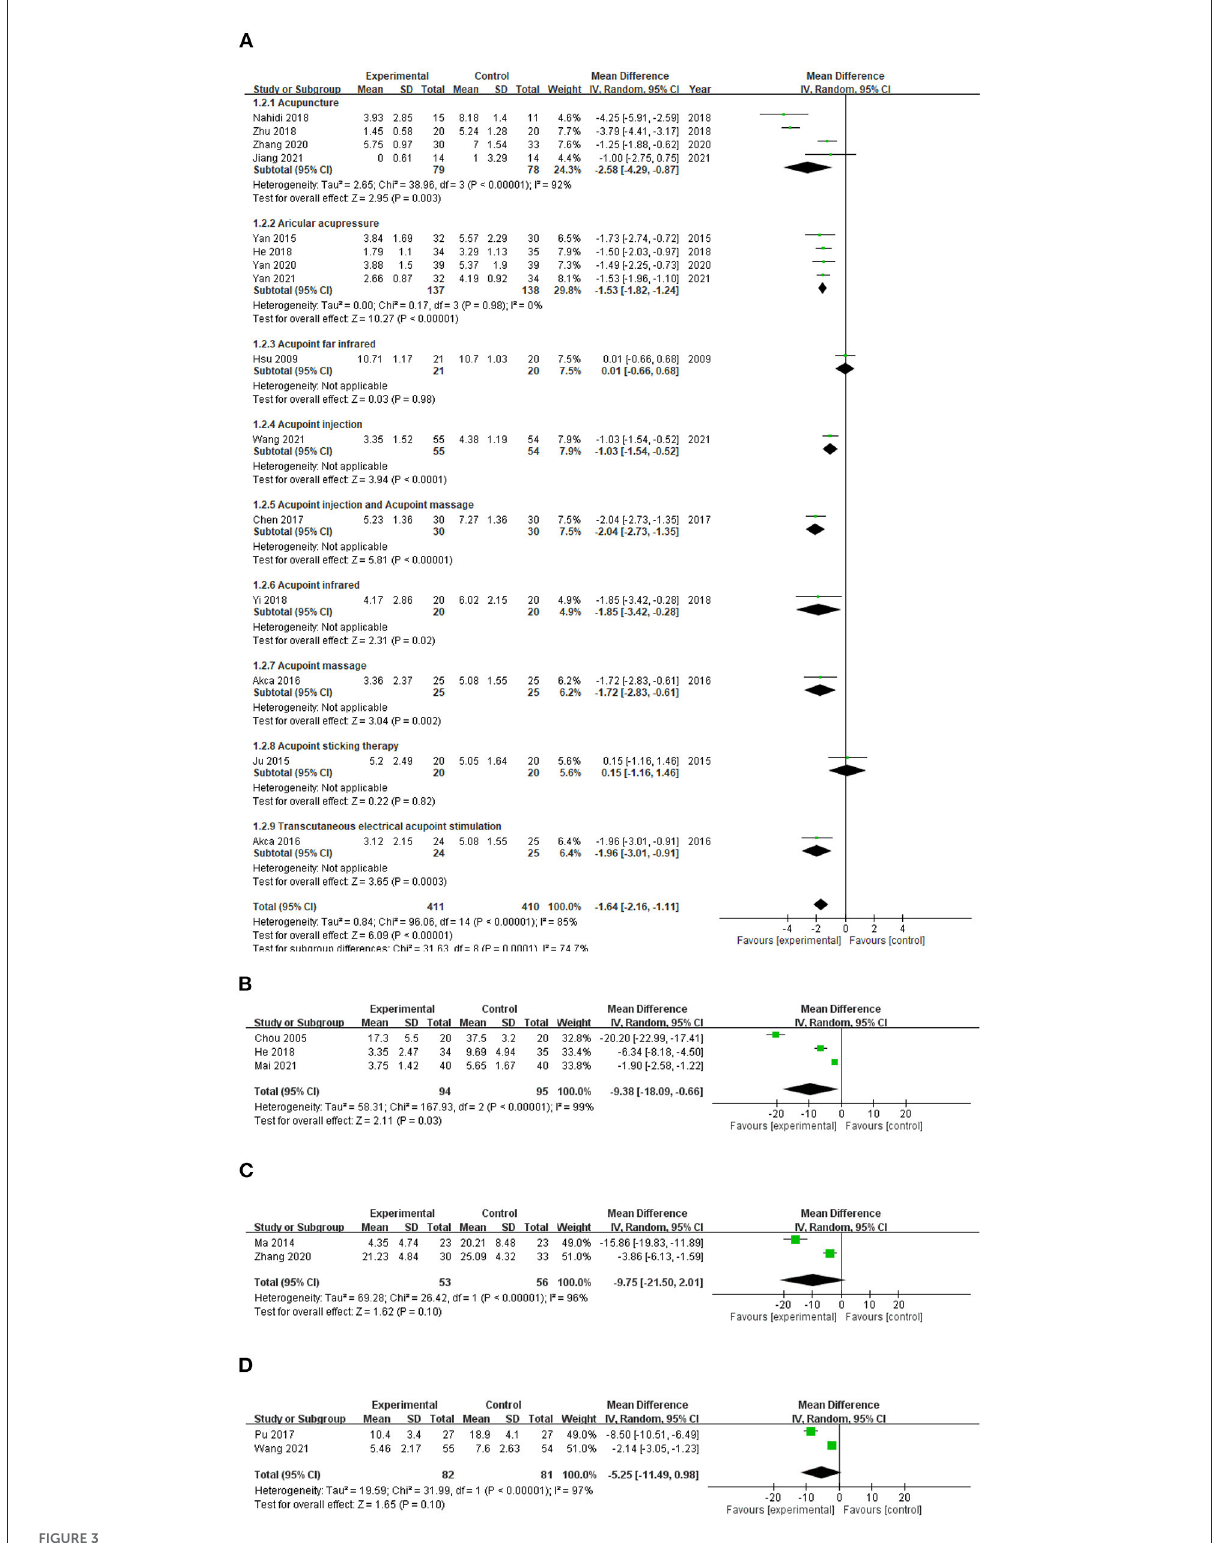
FIGURE3 Forest plot comparison of pruritus scores on (A) visual analog scale, (B) Pauli-Magnus scale, (C) modified Duo’s pruritus score, and (D) Dirk R. Kuypers scale in patients with uremic pruritus treated with acupuncture. CI, confidence interval; df, degrees of freedom; IV, independent variable; SD, standard